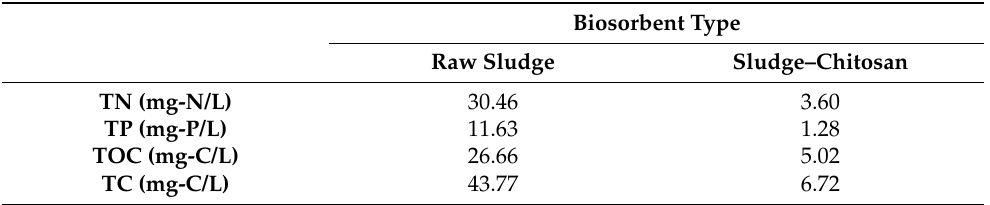
Table 1. Values of TN, TP, TOC, and TC released from raw sludge and sludge–chitosan (experimental condition: sample dosage 2 g/L, solution volume 200 mL, and elution time 12